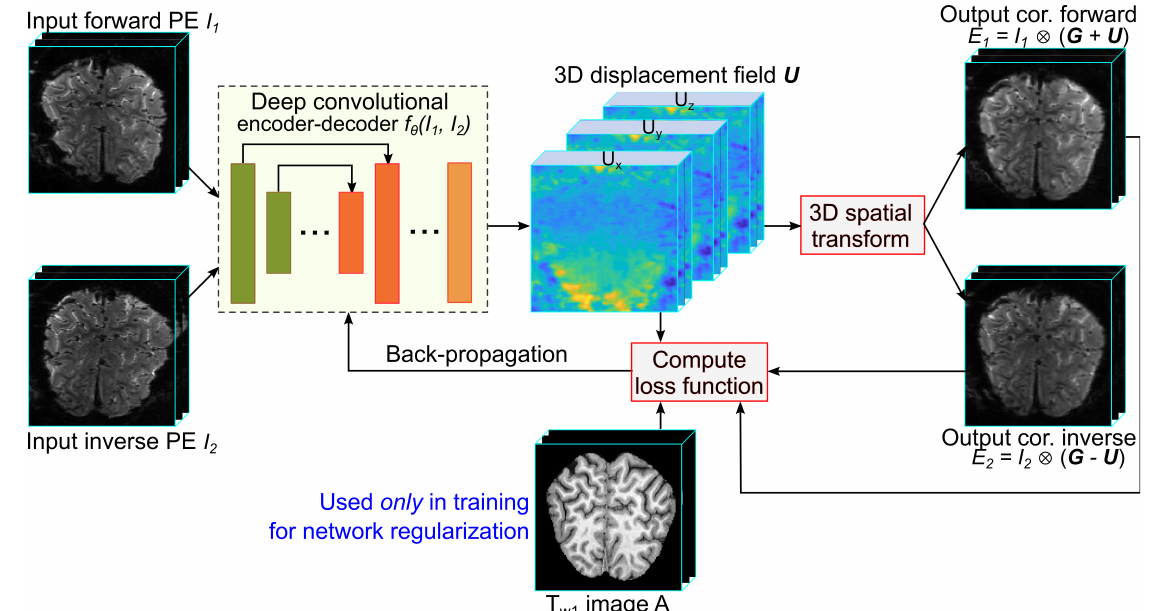
Figure 1. The proposed learning framework (TS-Net) for correcting the SAs in reversed-PE images. TS-Net accepts a pair of 3D reversed-PE images and produces the 3D displacement field and the corrected